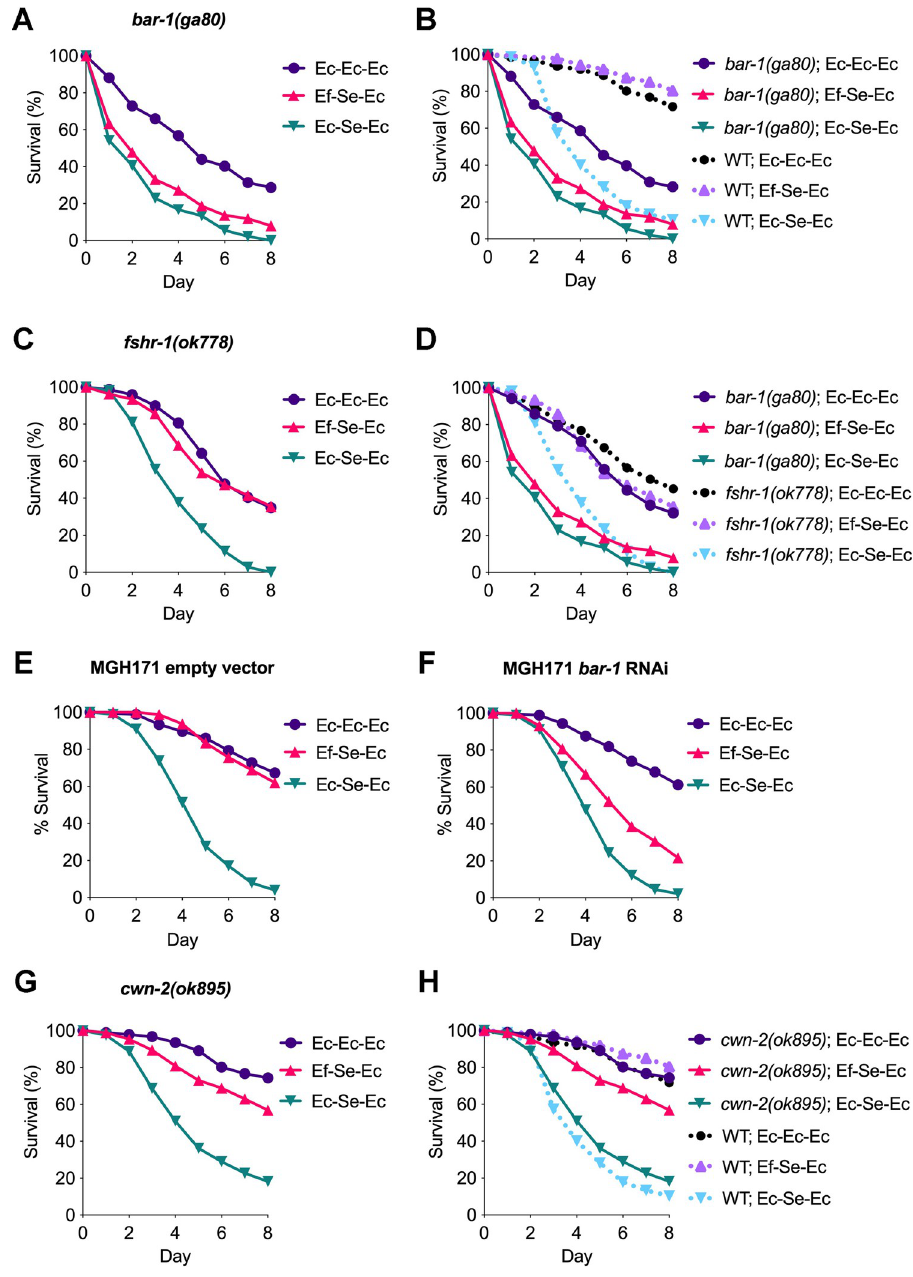
Fig 5. Bar-1 is required in E . faecium protection against S . enterica infection. (A) Survival curve assaying E . faecium –mediated protection in bar-1(ga80) animals. (B) Comparison of E . faecium –mediated protection between bar-1(ga80) animals and wild-type N2 animals. WT; Ec-Ec-Ec versus bar-1(ga80) ; Ec-Ec-Ec, P < 0.0001; WT; Ef-Se-Ec versus bar-1(ga80) ; Ef-Se-Ec, P < 0.0001; WT; Ec-Se-Ec versus bar-1(ga80) ; Ec-Se-Ec, P < 0.0001. (C) Survival curve assaying E . faecium –mediated protection in fshr-1(ok778) animals. (B) Comparison of E . faecium –mediated protection between bar-1(ga80) animals and fshr-1(ok778) animals. Fshr-1(ok778) ; Ec-Ec-Ec versus bar-1(ga80) ; Ec-Ec-Ec, P < 0.05; fshr-1(ok778) ; Ef-Se-Ec versus bar-1(ga80) ; Ef-Se-Ec, P < 0.0001; fshr-1(ok778) ; Ec-Se-Ec versus bar-1(ga80) ; Ec-Se-Ec, P < 0.0001. Survival curves assaying E . faecium –mediated protection in the intestine-specific RNAi strain MGH171 feeding on HT115 expressing empty vector or (F) bar-1 RNAi animals. (G) Survival curve assaying E . faecium –mediated protection in cwn-2(ok895) animals. (H) Comparison of E . faecium –mediated protection between cwn-2(ok895) animals and wild-type N2 animals. WT; Ec-Ec-Ec versus cwn-2(ok895) ; Ec-Ec-Ec, P = NS; WT; Ef-Se-Ec versus cwn-2(ok895) ; Ef-Se-Ec, P < 0.001; WT; Ec-Se-Ec versus cwn-2(ok895) ; Ec-Se-Ec, P = NS. The data underlying all the graphs shown in the figure can be found in S1 Data. NS, nonsignificant; RNAi, RNAi interference; WT, wild- type.